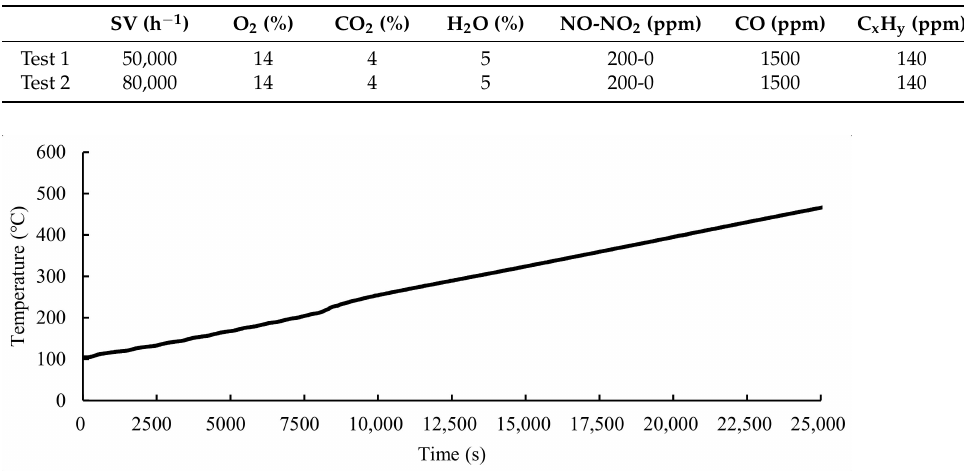
Table 3. Component composition for DOC SGBT.